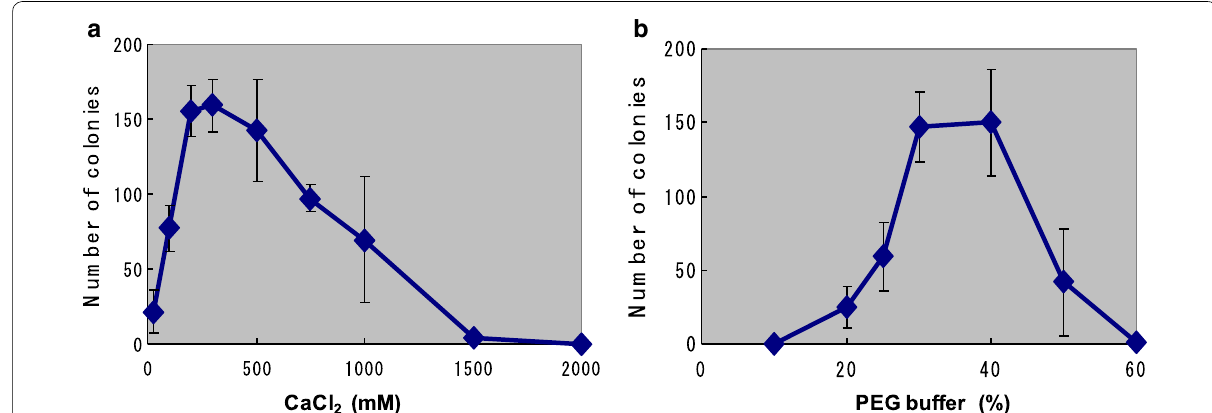
Fig. 2 Optimization of conditions for transformation in C. subvermispora . Number of drug-resistant colonies on the first screening plate containing 100 µg/ml hygromycin B (n 3, SD) with various concentrations of CaCl 2 in the presence of 40% PEG ( a ) and various concentrations of PEG in the = ± presence of 300 mM CaCl